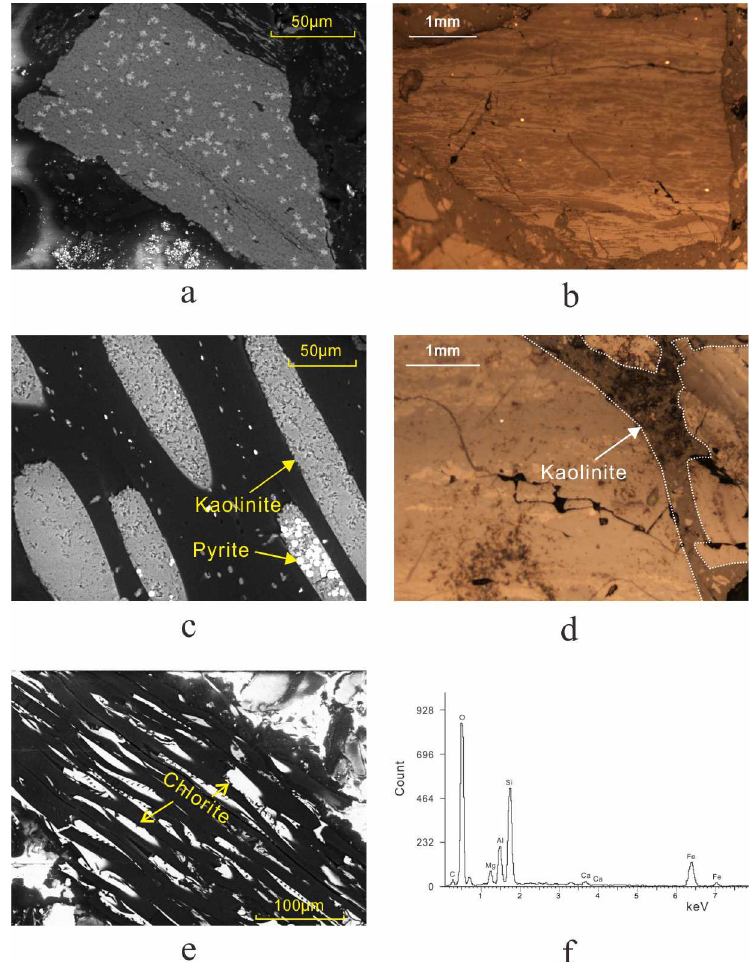
Figure 4. Clay minerals in the coal of Huainan coalfield. ( a ) Kaolinite occurring as a matrix under the SEM, S11, Xinzizhuang (XZZ) mine, No. 8 coal seam; ( b ) kaolinite intimately admixed with maceral under an optical microscope, reflected light, S9, P1 mine, No. 11-2 coal seam, 200×; ( c ) kaolinite occurring as cell infillings intergrown with pyrite under a SEM, S10, GQ mine, No. 8 coal seam; ( d ) kaolinite occurring as fracture infillings under an optical microscope, reflected light, S9, P1 mine, No. 11-2 coal seam, 200×; ( e ) chlorite occurring as compressed cell infillings under a SEM, S16, P1 mine, No.3 coal seam; ( f ) X-ray EDS spectrum of chlorite in panel ( e ).